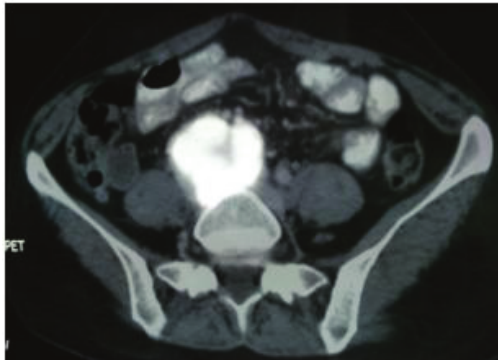
Figure 2: PET CT axial cut showing intense tracer uptake in the pelvic mass abutting the right psoas muscle.